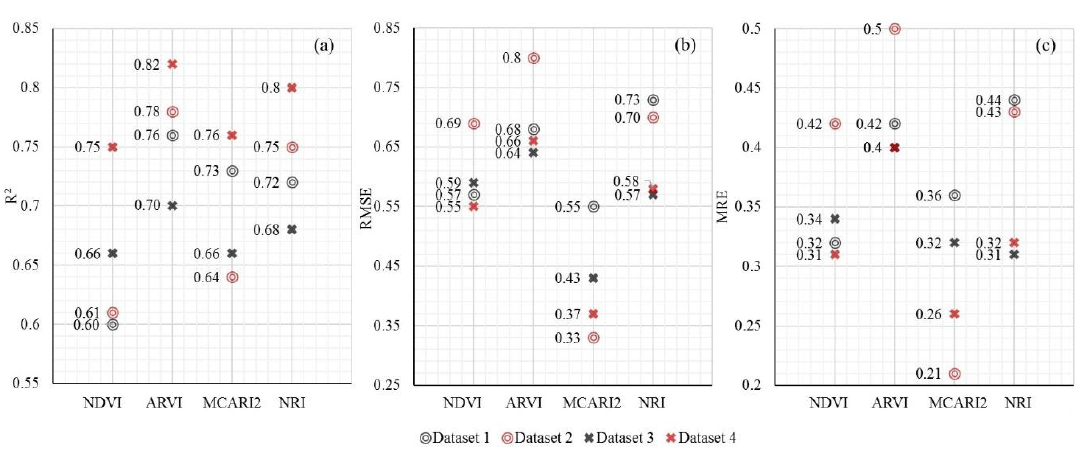
Figure 9. ( a ) R 2 , ( b ) RMSE, and ( c ) MRE for linear regression between measured LAI and simulated LAI of four datasets based on VI-LUTs (Datasets with optimized central wavelengths are in red: Datasets 2 and 4; datasets without optimizing central wavelengths are in black: Datasets 1 and 3. Datasets with broad bandwidths are denoted as dots: Datasets 1 and 2; datasets with narrow bandwidths are denoted as the crosses: Datasets 3 and 4).